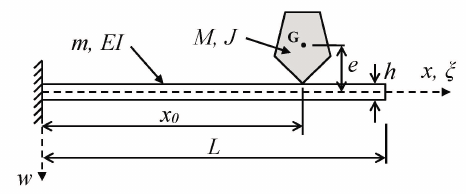
Figure 1. Schematic of a uniform cantilever beam supporting a rigid mass of arbitrary shape and size attached at an arbitrary point. The finite size and shape of the attached mass are reflected in its eccentricity e and its mass moment of inertia J with respect to the out-of-plane axis through G . (Point G is the center of mass of the attached